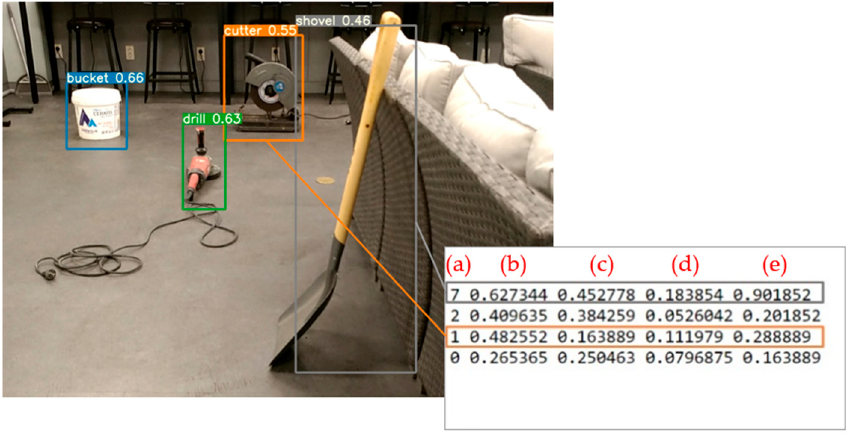
Figure 11. Sample result images and corresponding result text fi le.